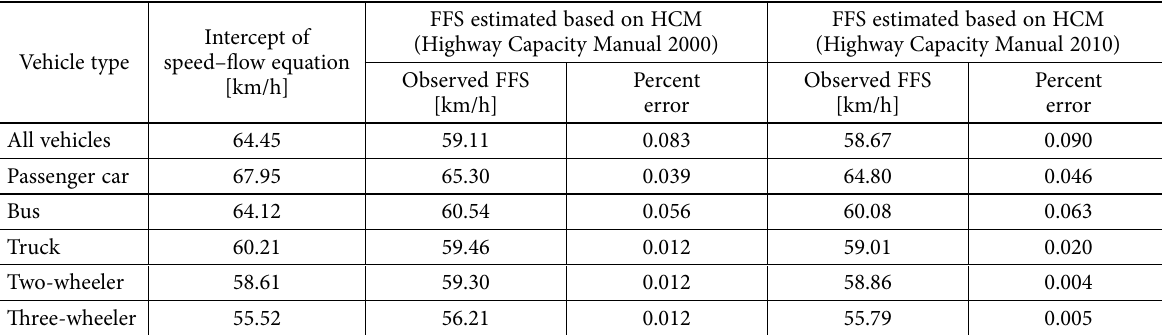
Fig. 7. Speed–flow relationship at uncongested flow condition for: a – car; b – bus; c – truck; d – two-wheeler; e – three-wheeler Table 4. Comparison of free-speeds estimated based on HCM guidelines with intercept of speed–flow